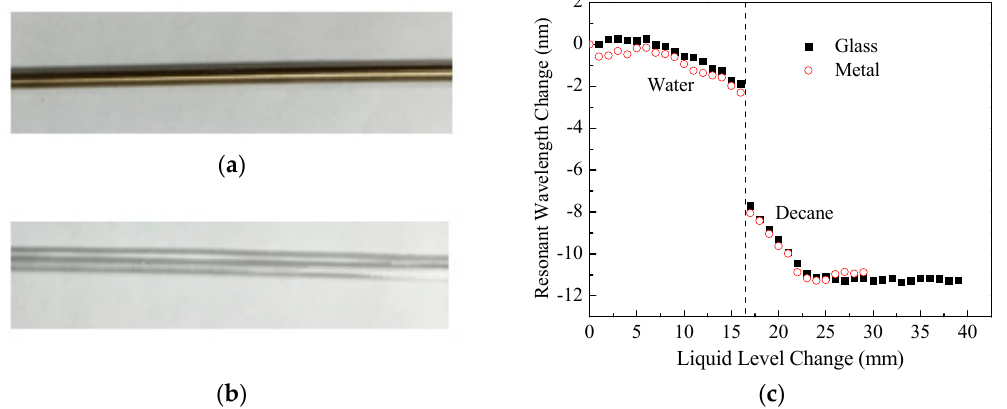
Figure 9. ( a ) Metal holding rod of 3 mm; ( b ) Glass holding rod of 3 mm; ( c ) Resonant wavelength changes of the LP 07 vs layered liquid changes for two holding rods with different materials: metal and glass in layered liquids of water and decane.